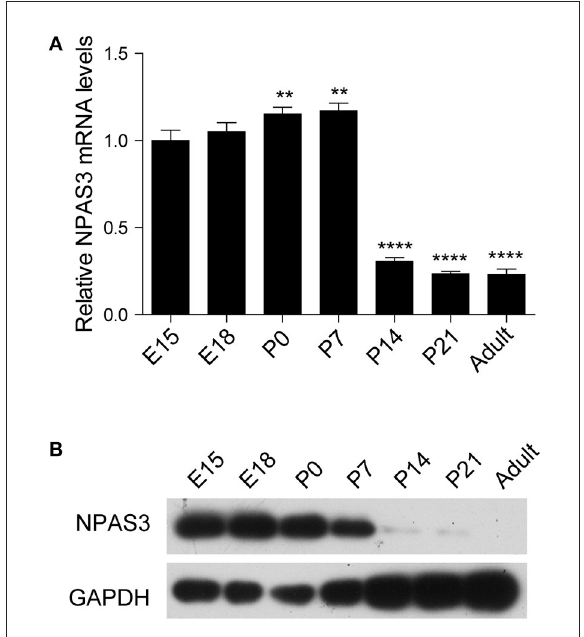
FIGURE1 The expression of Npas3 in the developing mouse cerebral cortex. (A) Quantification for Npas3 mRNA levels in the developing cerebral cortex at the indicated stages obtained by RT-PCR. Data are presented as mean ± SEM ( n = 3). One-way ANOVA test, ** p < 0.01, **** p < 0.0001. (B) Western blot analysis of NPAS3 protein levels in the developing cerebral cortex at the indicated stages. GAPDH was used as a loading